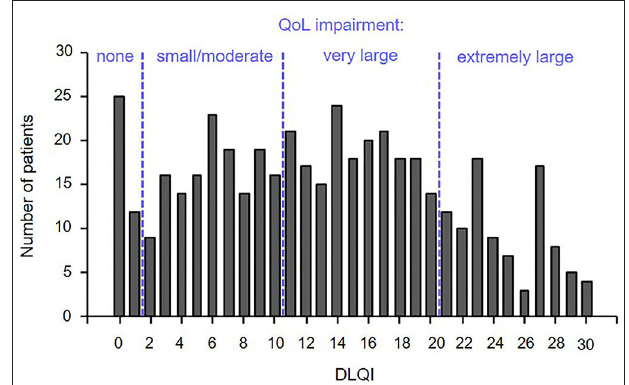
FIGURE 2 | More than half of the patients with HS showed a severe QoL impairment. QoL was assessed by means of the DLQI questionnaire in 462 patients with HS. The numbers of patients scoring a certain DLQI value is indicated. DLQI category: 0–1 = no effect on patient’s life, 2–10 = small